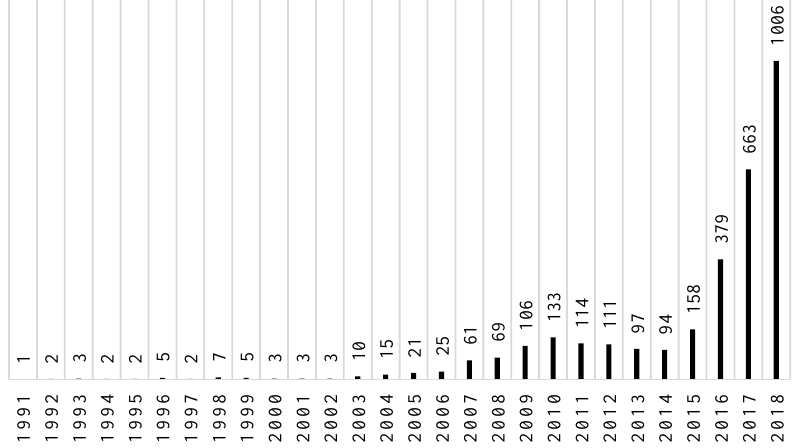
Figure 1. Search results for a topic circular economy by publication years from 1991 to